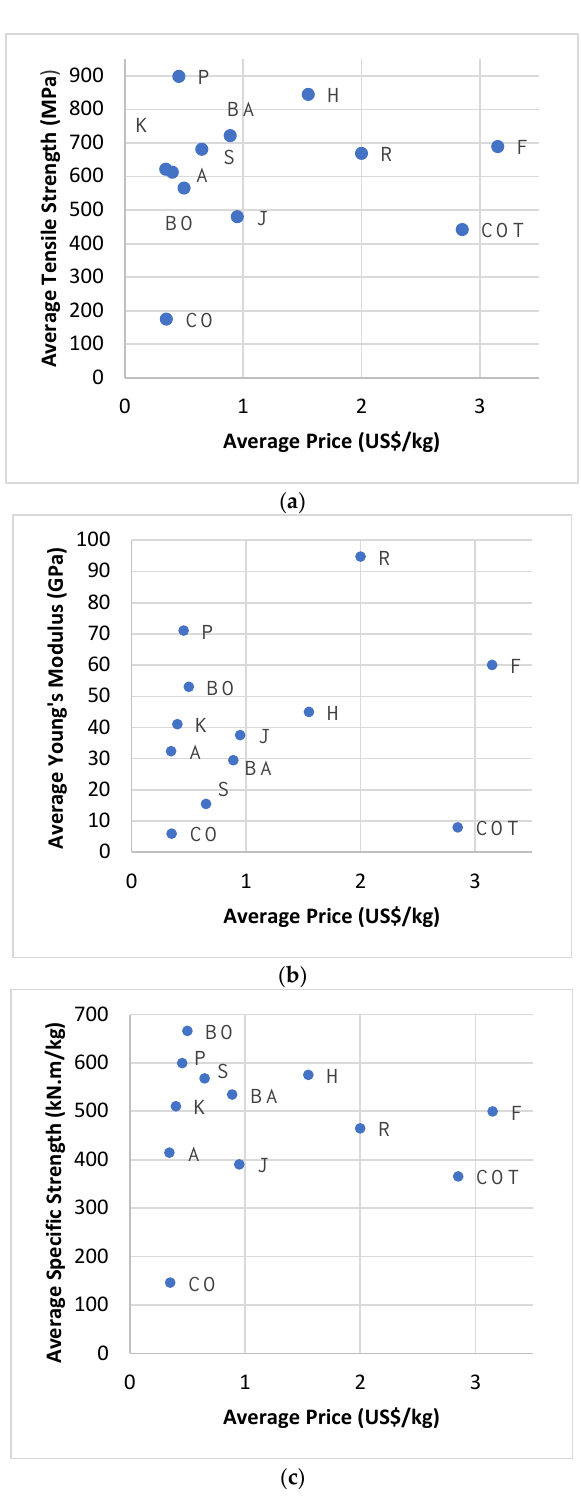
Figure 5. Interrelationships between mechanical properties and price (average values in Tables 5 and 6 were used). ( a ) Average Tensile strength (MPa); ( b ) Average Young’s Modulus (GPa); ( c ) Average Specific strength (kN·m/kg) per Price (US$/kg), respectively. Legend: Abaca (A); Bamboo (BO); Banana (BA); Coir (CO); Cotton (COT); Flax (F); Hemp (H); Jute (J); Kenaf (K); Pineapple (P); Ramie (R) and Sisal (S).